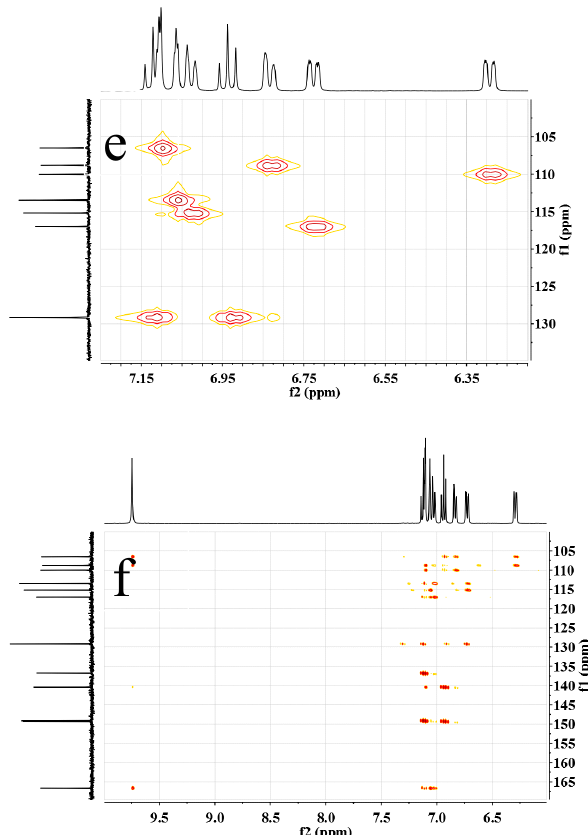
Figure 2. ( a ) 1 H NMR, ( b ) 13 C NMR, ( c ) H–H COSY, ( d ) C–H QC and ( e ) C–H BC spectra of m- DABPI in DMSO- d 6 .